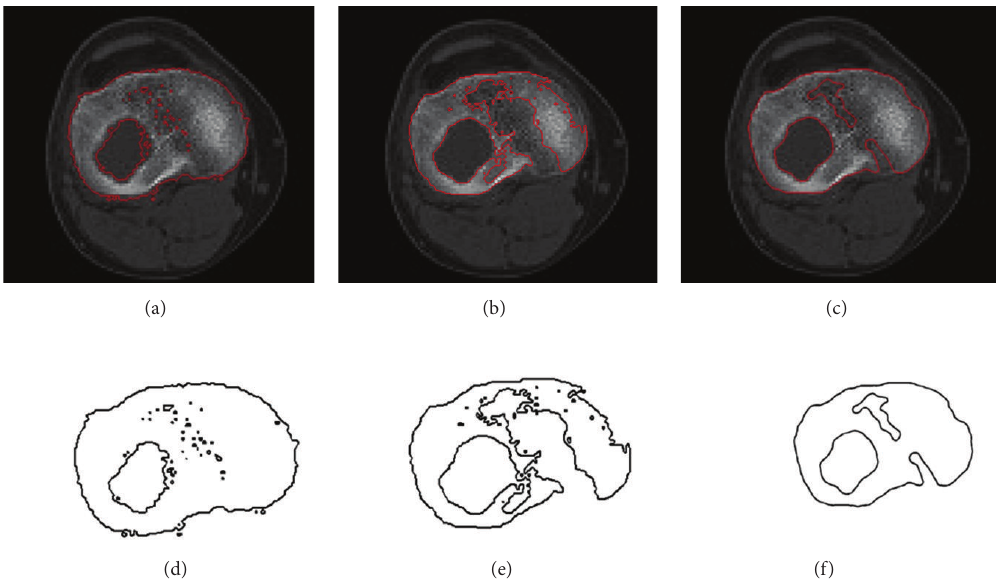
Figure 5: The segmentation results of the CT image: (a) and (d) results using CV model, (b) and (e) results using LBF model, and (c) and (f) results using the new